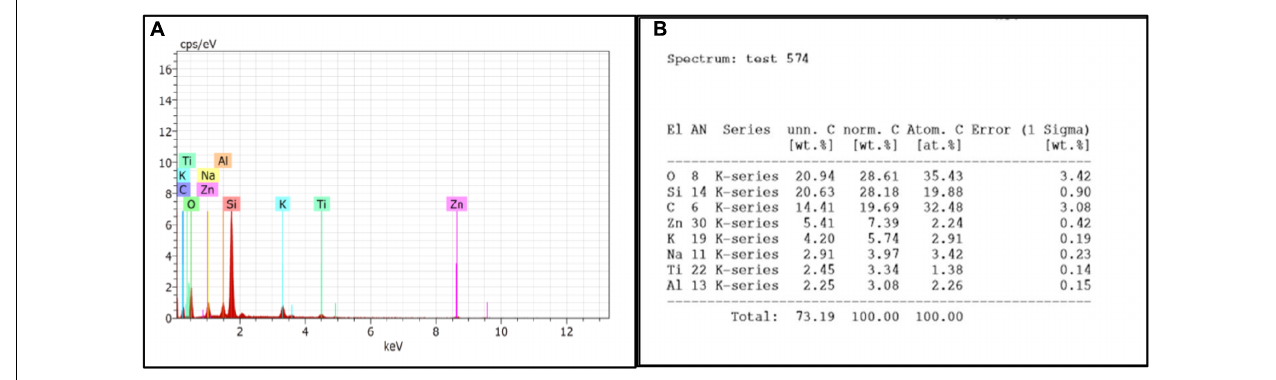
FIGURE 6 | (A) EDS graph represents the count per second on x -axis and the kilo electron volt which it is generated is on y -axis. (B) Showing percentage of elements present in control biofilm.